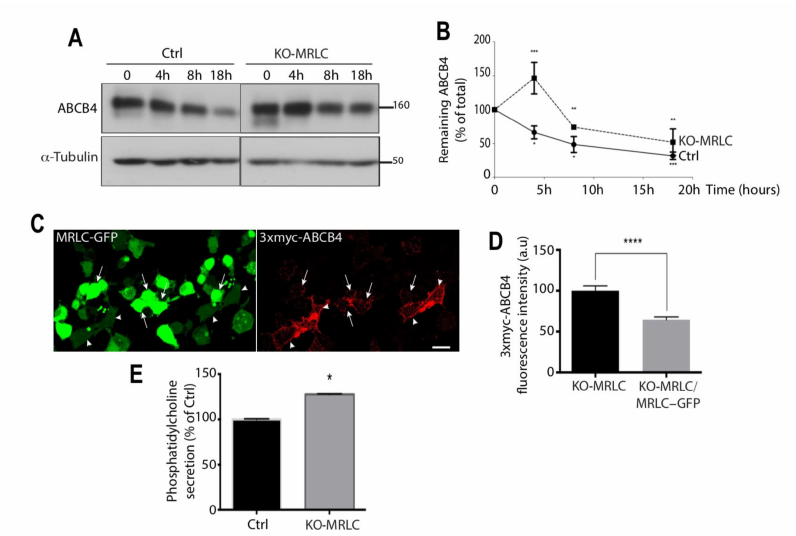
Figure 6. Impact of MRLC depletion on ABCB4 membrane stability. ( A ) Control HEK-293 cells (Ctrl) or HEK-CRISPR for MRLC (KO-MRLC) were transfected with ABCB4. After 24 h, cycloheximide (25 mg/mL) was added to the culture medium to inhibit protein synthesis. Expression of ABCB4 was analyzed by immunoblotting at the indicated time points, using equal amounts per line. a-Tubulin served as a loading control. Presented data were cropped from the full immunoblots shown in Supplementary Figure S6. ( B ) Amounts of ABCB4 were quantified from chase experiments. The amount of ABCB4 at time zero was considered to be 100%. The remaining ABCB4 at later time points was expressed as percentage of time zero. Means ( ± SD) of three independent experiments are shown. *** p < 0.001; ** p < 0.01; * p < 0.05. ( C ) MRLC is involved in the regulation of ABCB4 cell surface